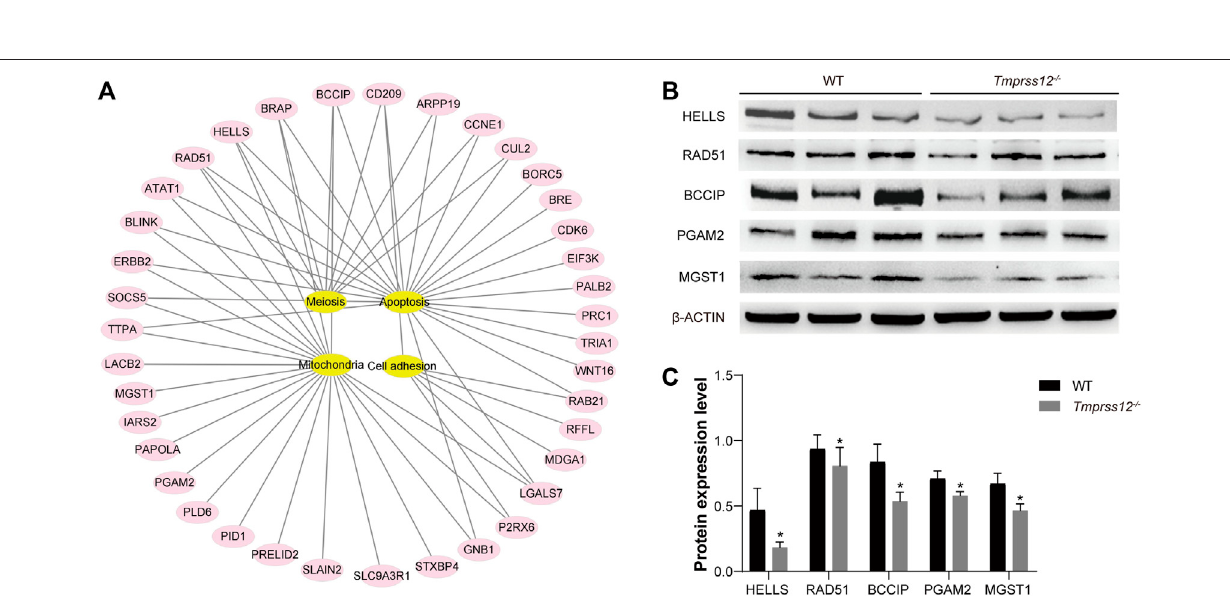
FIGURE8| Analysisofdifferentialprotein expression pro fi les oftestes from WT and Tmprss12 − / − mice. (A) Proteins showing adifference ofmore than 2-fold were analysed according to IPA (ingenuity pathway analysis), and they were mainly related to meiosis, apoptosis, mitochondrial function and cell adhesion. (B) Veri fi cation of the expression levels of some differential proteins related to key events in WT and Tmprss12 − / − mouse testes by western blot. β -ACTIN was used as an internal control. (C) Grey intensity analysis showing the expression level of the above proteins. The results were consistent with the differential expression pro fi les ( n = 3). Data are the mean ± s.d. p p <